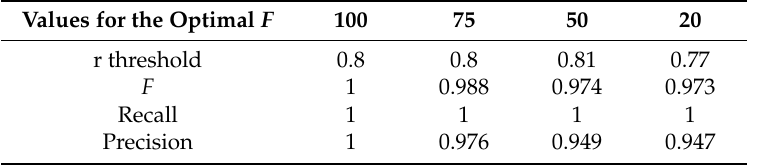
Table 3. Optimal values for the F score for each configuration.